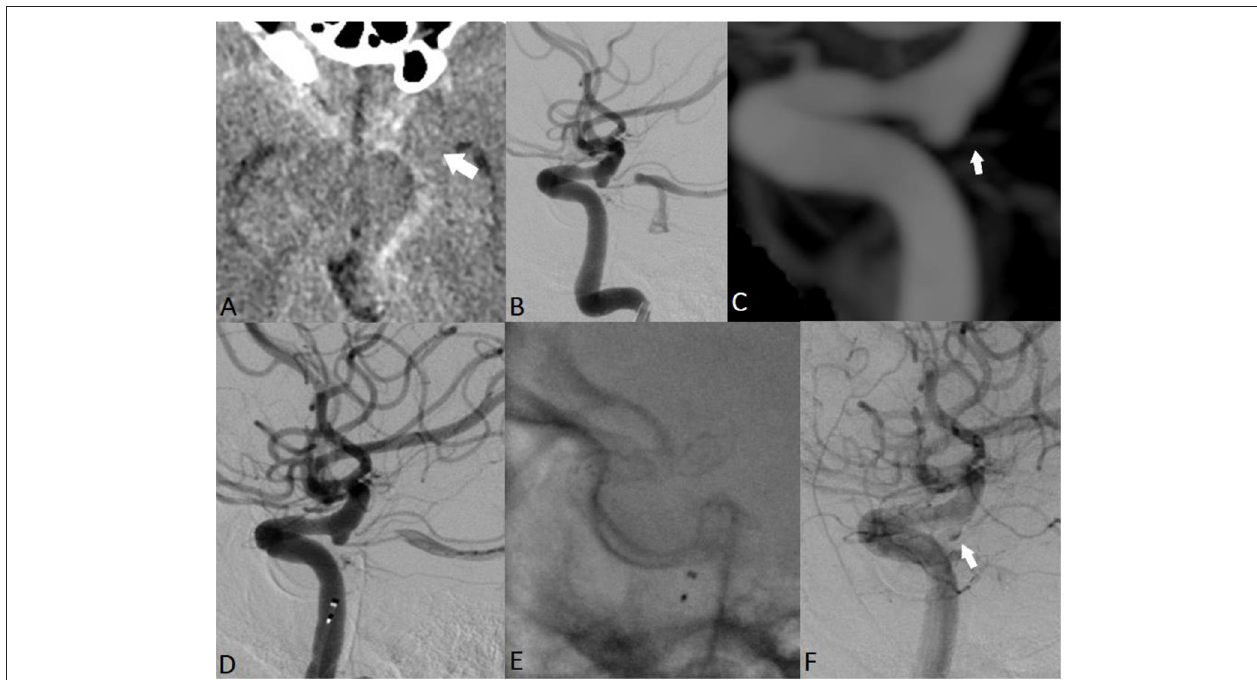
FIGURE 4 | EVT of a ruptured PcomA ID in a 60-year-old man. Non-contrast cranial CT revealed a thin hemorrhage in the chiasmatic, interpeduncular, and left crural cisterns ( A ; white arrow). Subsequent repeated radiological examinations did not reveal any cerebrovascular pathology but confirmed the presence of an ID at the level of the left PcomA ( B,C ; white arrow). The assumed rupture site was the observed ID, and the patient received EVT (D,E) . Noticeable contrast stagnation was observed in the PcomA ID after stent implantation (F)